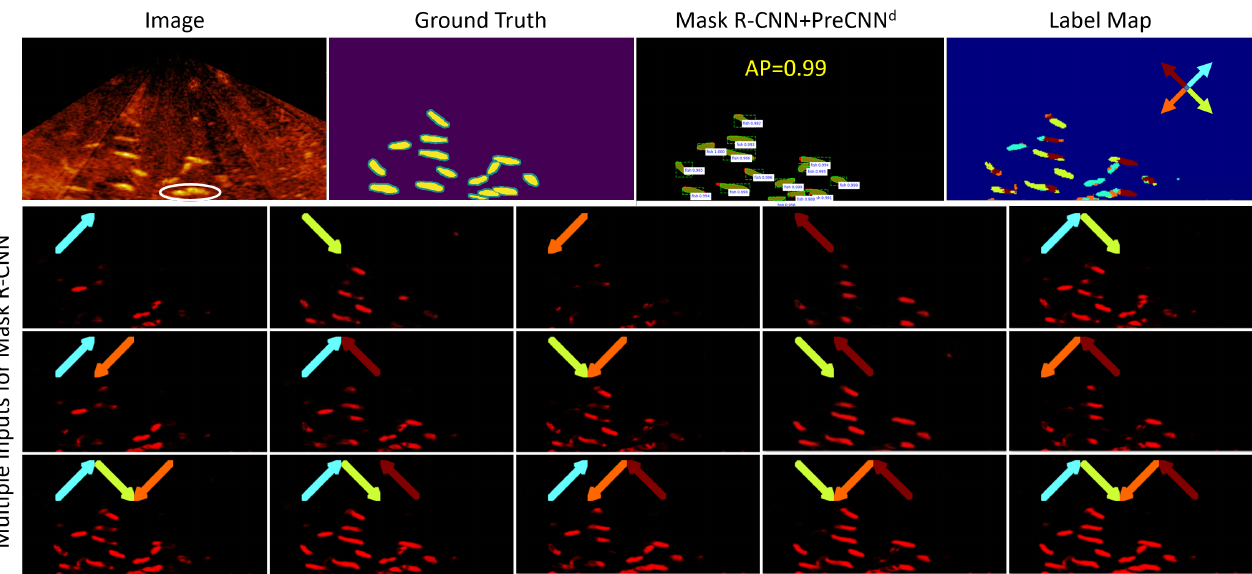
Figure 10. An example of segmenting overlapping fish by Mark R-CNN+PreCNN d , where the overlapping fish are highlighted by a circle and the label map is yielded according to the output Q of PreCNN d